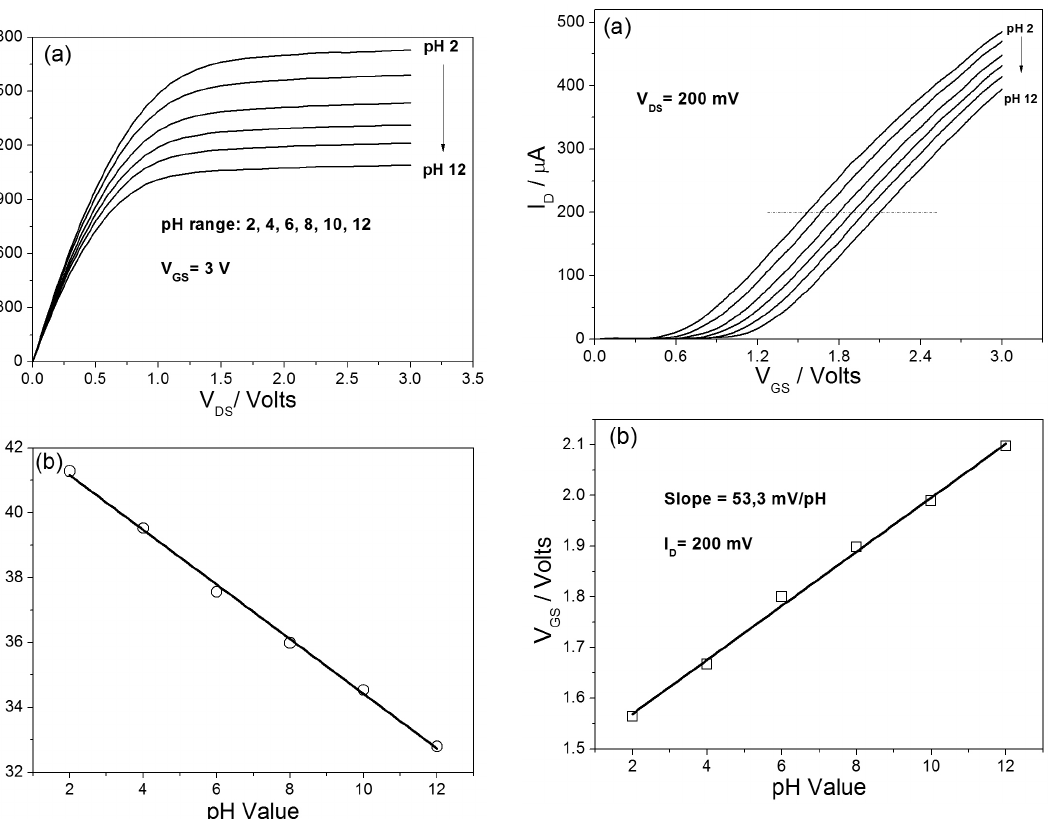
of the ITO film as DS -V D GS was fixed in D